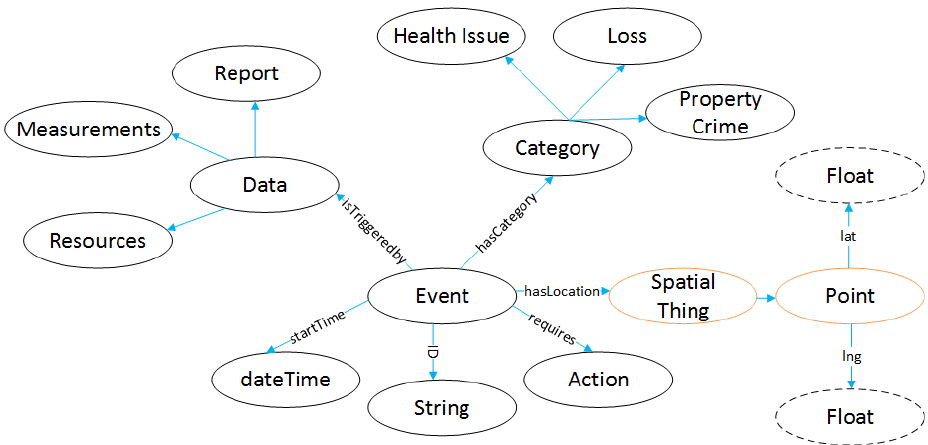
Figure 10. Event entity.